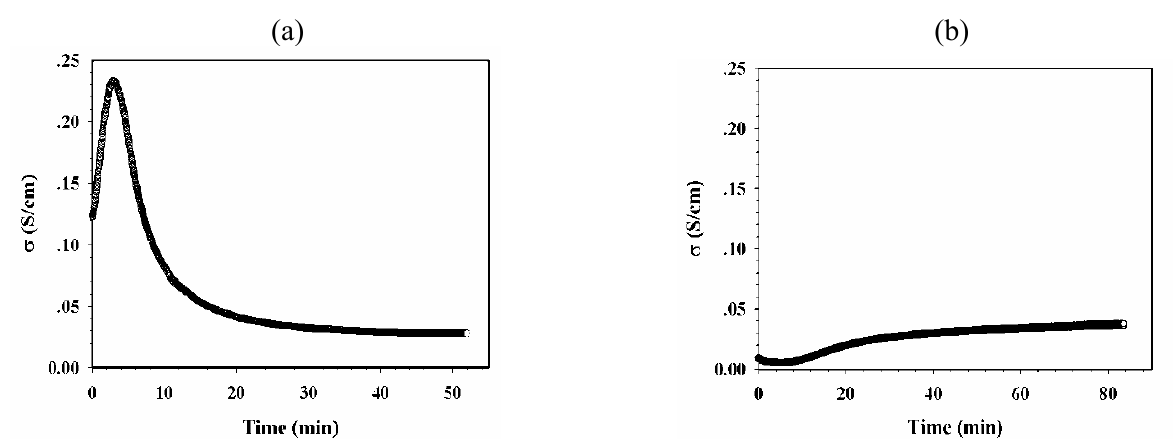
Figure 5. of 50:1dPPP vs . NH / σσΔ N 2